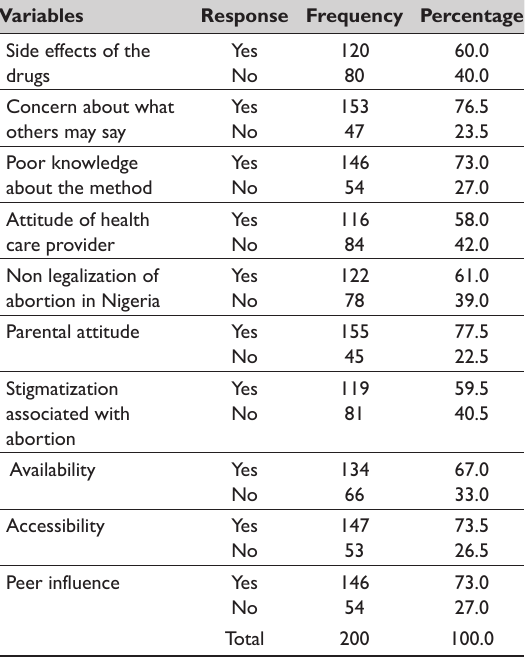
Table 5. Factors influencing the utilization of emergency contraceptive pills (n=200)